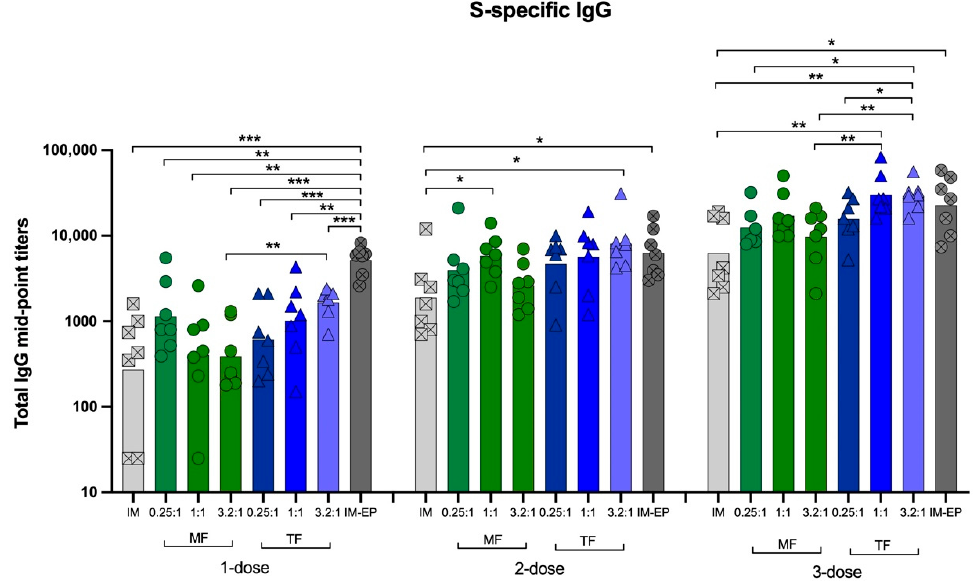
Figure 10. Midpoint titers of SARS-CoV-2 spike-specific total IgG analyzed at weeks 2, 4 and 6 in mice immunized intramuscularly with naked-pCMVkan-S (IM; crossed square), pCMVkan-S formulated with DOTAP4 at N/P ratios of 0.25:1, 1:1 and 3.2:1 manufactured by thin-film rehydration (TF; triangle) or microfluidics (MF; circle) methods and by using an electroporation device (IM-EP; crossed square). Each bar represents GMT of the midpoint IgG titers in each group ( n = 7). *, **, and *** indicate p < 0.05, p < 0.01 and p < 0.001, respectively.